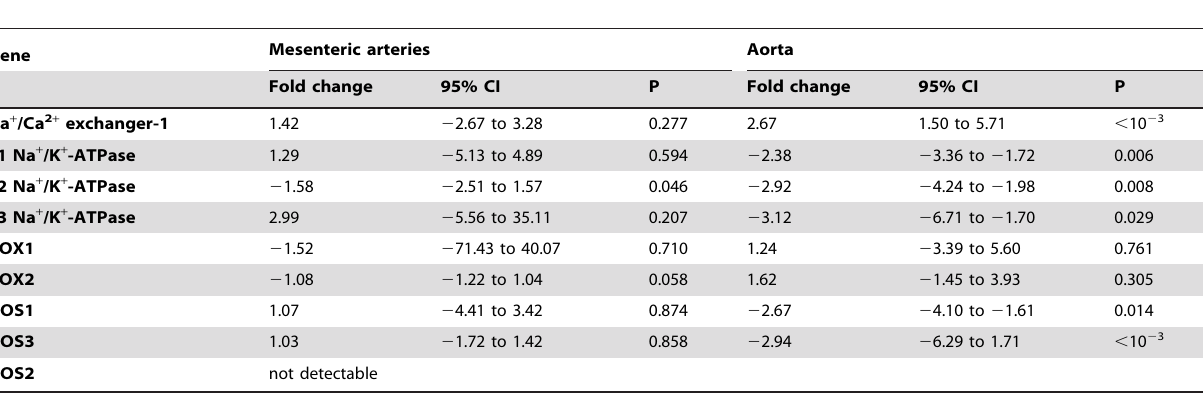
Table 1. Effect of ouabain treatment (324 m g/kg/day) on gene expression in the mesenteric arteries and the aorta.